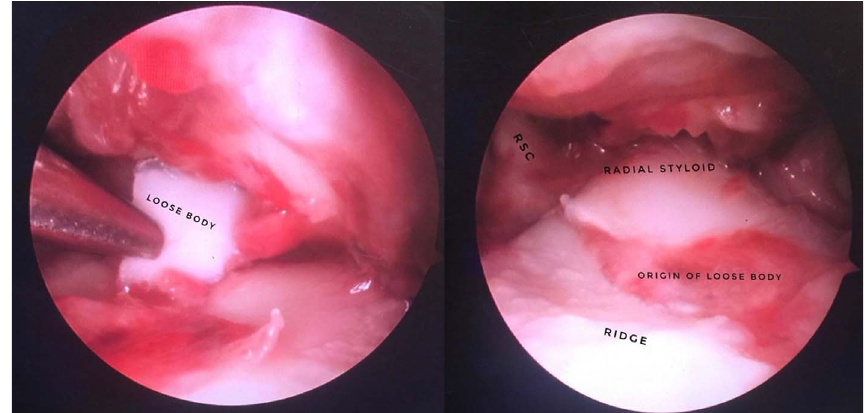
Figure 6. Arthroscopic view of a loose body in radio-carpal joint and its origin that lead to osteochondral defect in the articular surface of the radius.